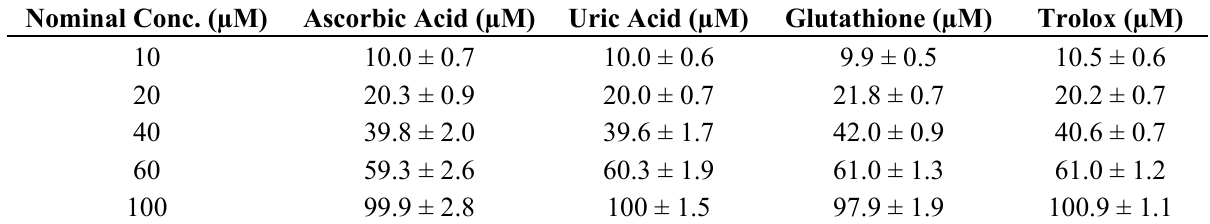
Table 4. Back calculated concentrations of standards for ascorbic acid, uric acid, glutathione and